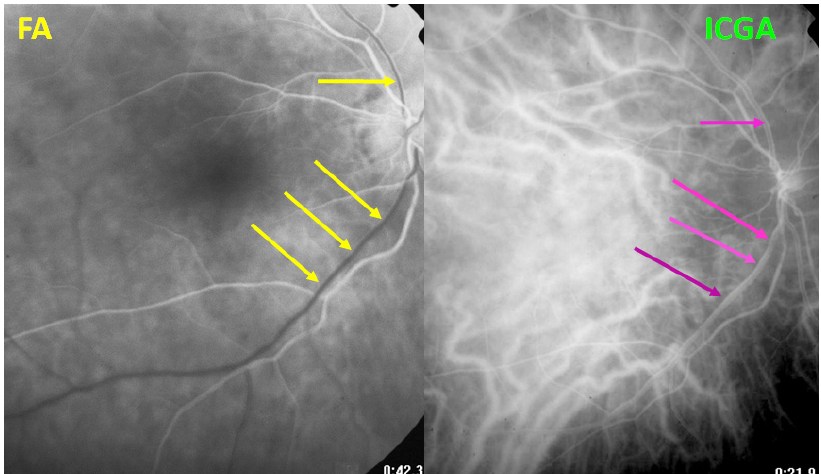
Figure 6. HLA-A29 birdshot retinochoroiditis. Close-up on discrepancy between FA and ICGA imaging of large veins. After 42 ′′ , on FA, the veins are still not marked by fluorescein (yellow arrows); however, large veins are marked on the ICGA frame (crimson arrows) after 21.9 s.